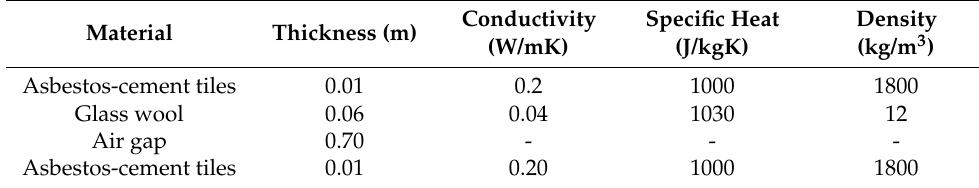
Table 4. Stratigraphy settings for roofing